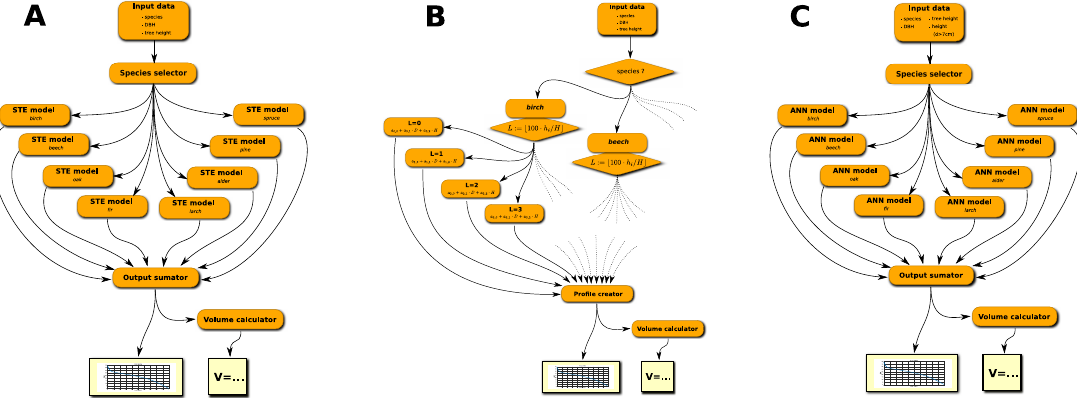
Figure 2. From left to right: ( A ) the stem taper equation (STE) model, ( B ) the regression tree (REG) model, and ( C ) the artificial neural network (ANN)